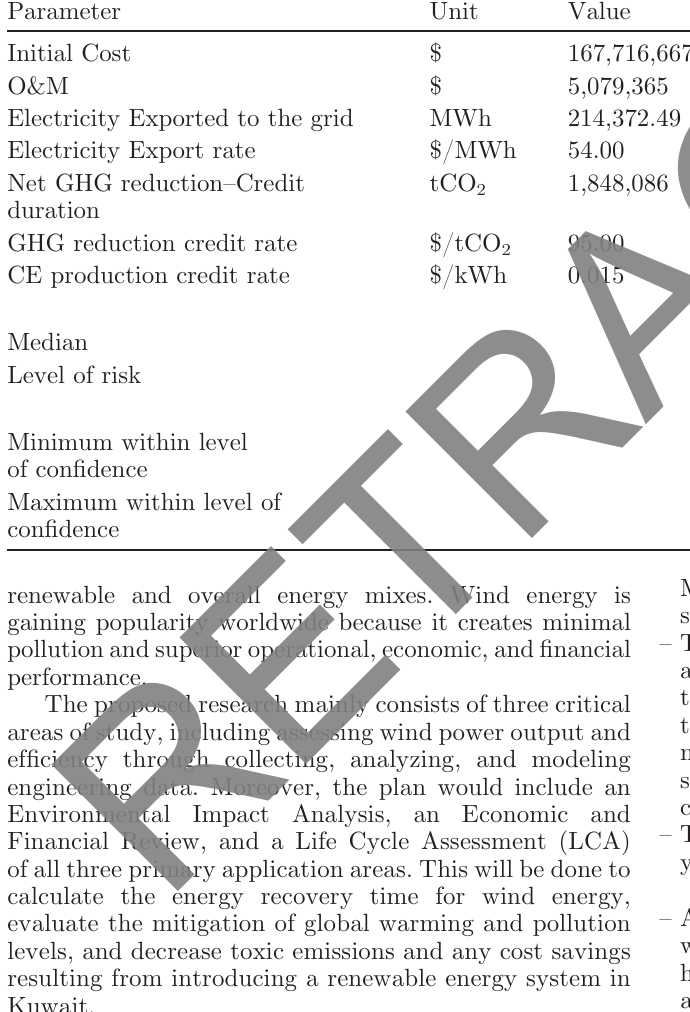
Fig. 18. Sensitivity analysis of GHG reduction credit rate for (a) pre-tax IRR asset analysis (b) NPV analysis. Table 8. Risk analysis summary of the wind